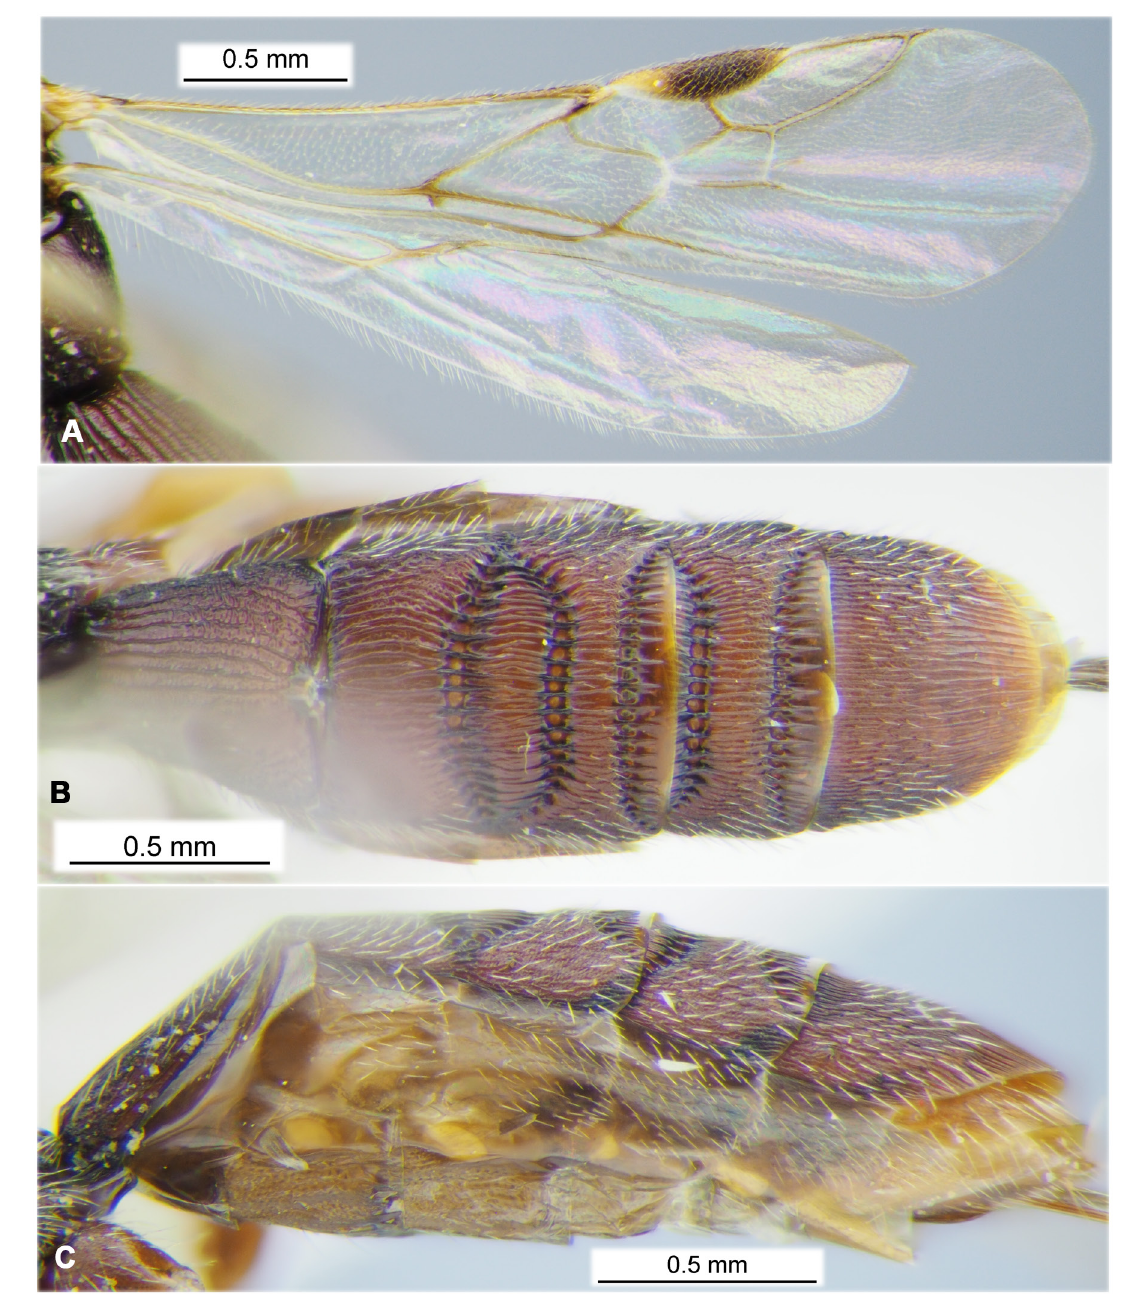
Fig. 50. Rhaconotus ( Rh. ) brevicellularis Belokobylskij sp. nov., holotype, ♀ (RMNH). A . Wings. B . Metasoma, dorsal view. C . Metasoma, lateral